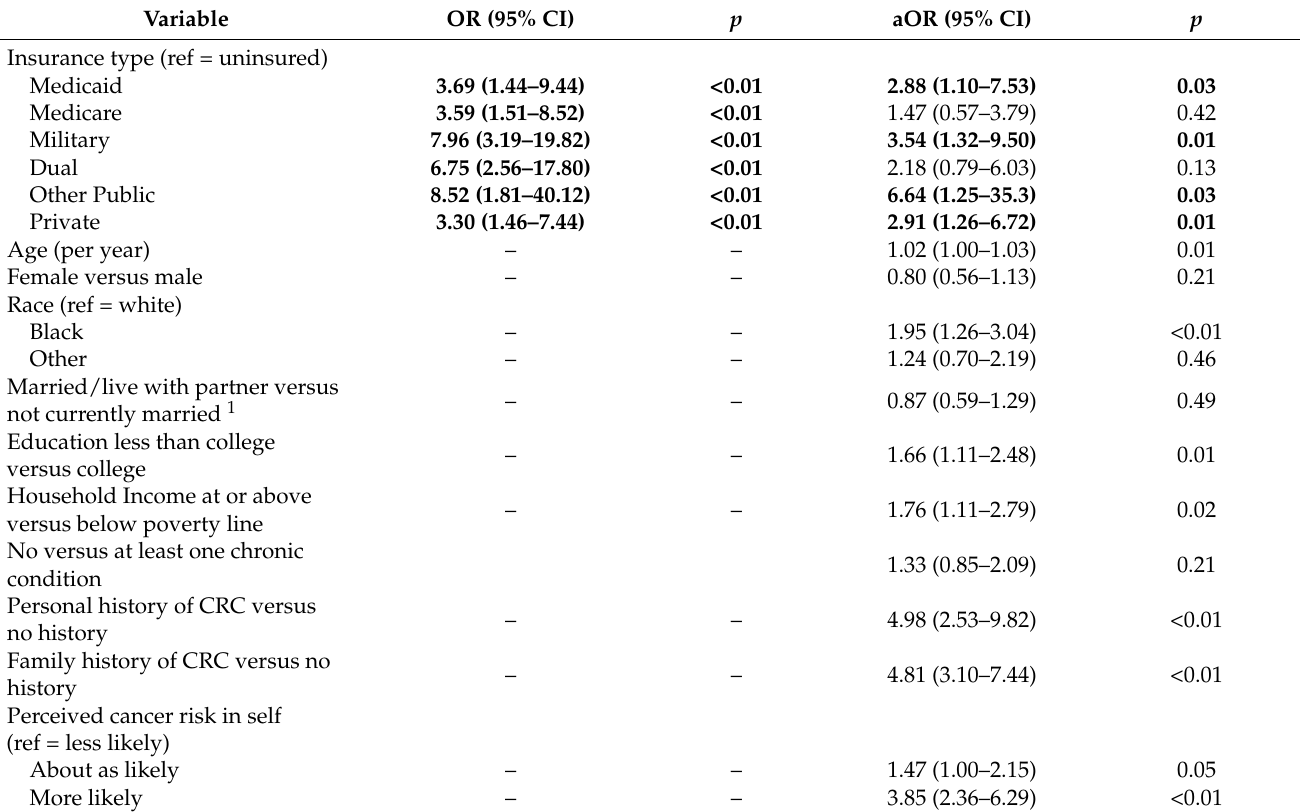
Table 2. Logistic Regression Evaluating Association Between Uptake of Genetic Testing/Counseling for Colorectal Cancer and Health Insurance